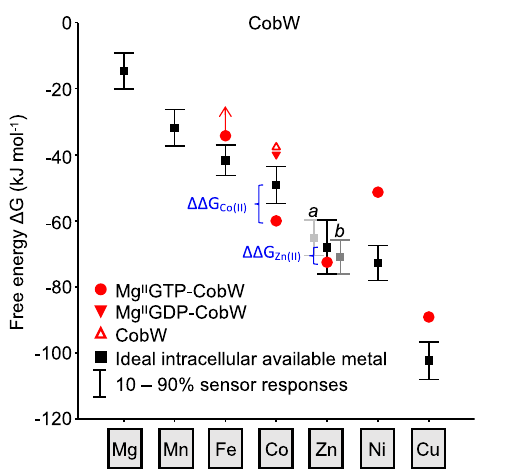
Fig. 5 Mg II GTP-CobW is predicted to acquire Co II or Zn II in a bacterial cell. Free-energy change ( Δ G ) for metal binding to Mg II GTP-CobW (red circles) plotted against the intracellular available free energies for metal binding in a reference bacterial cytosol (values correspond to Salmonella )